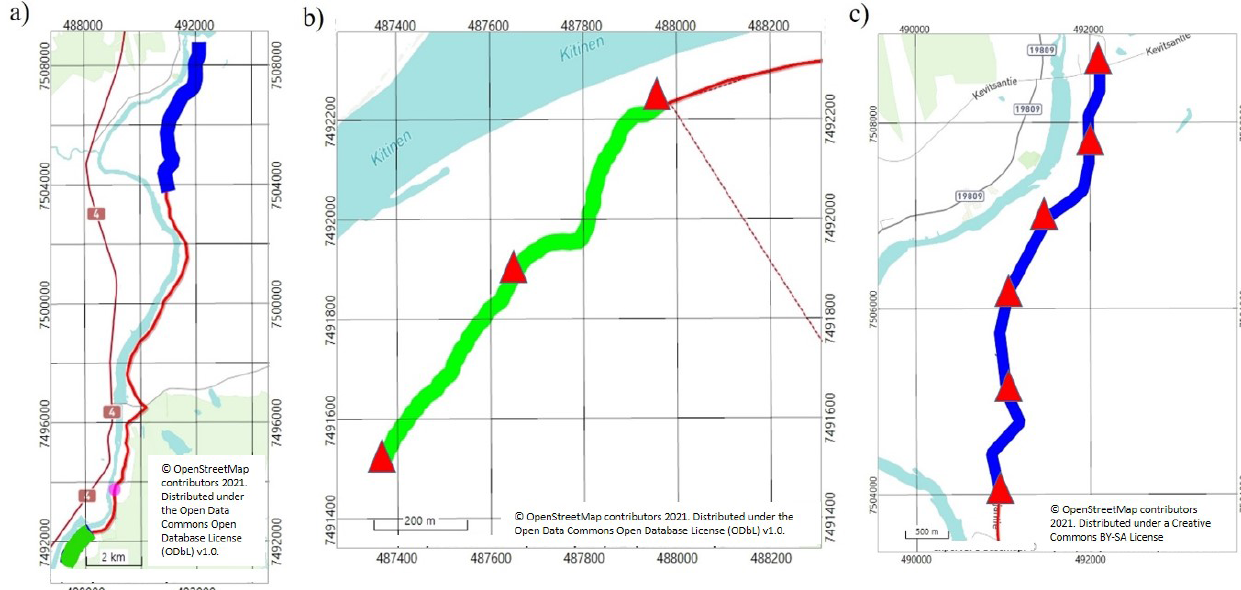
Figure 9. Location of passive seismic profiles of the XSoDEx Sakatti line: (a) positions of high-resolution line (green colour) and profile of lower resolution (blue line); (b) the high-resolution line in which red triangles mark positions of virtual sources; (c) profile of lower resolution (red triangles indicate positions of virtual sources).